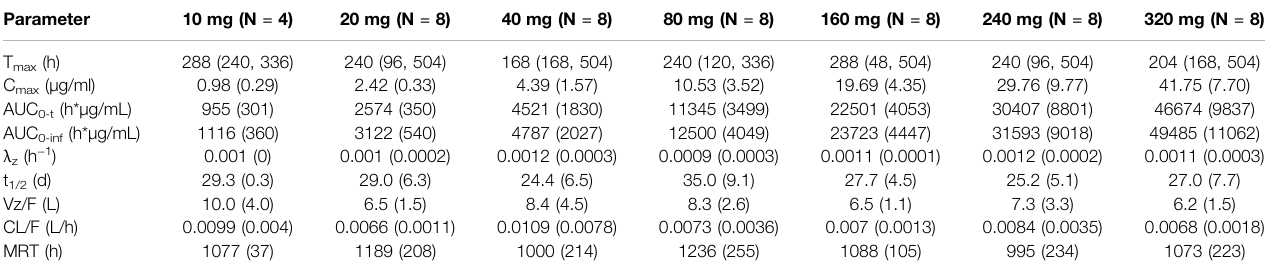
Frontiers in Pharmacology |